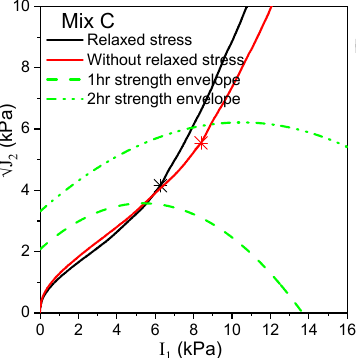
Figure 16. Stress path analysis and strength envelopes according to Bresler ‐ Pister